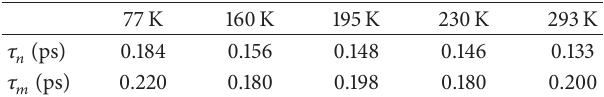
Table 3: The values of 𝜏 𝑛 and 𝜏 𝑚 for the different temperature at 10kPa. 77K 160K 195K 230 K 293 K 𝜏 𝑛 (ps) 0.184 0.156 0.148 0.146 0.133 𝜏 𝑚 (ps) 0.220 0.180 0.198 0.180